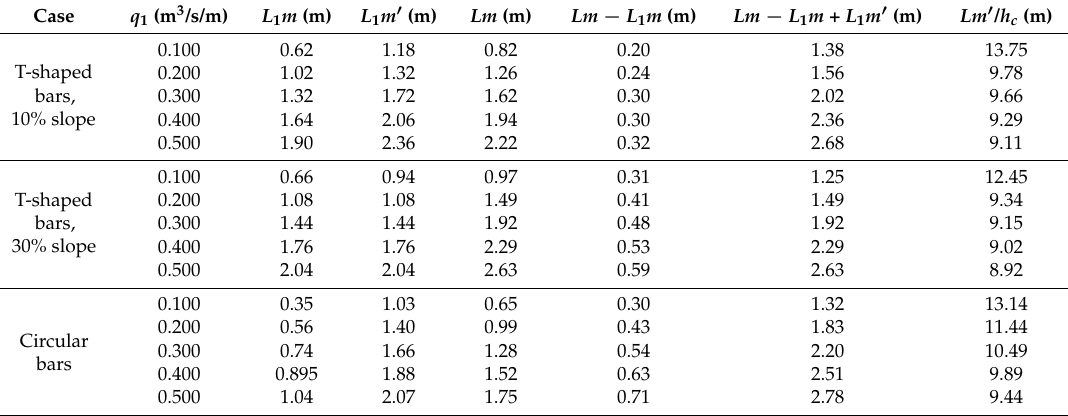
Table 6. Summary of lengths calculated to obtain the effective wetted rack length considering gravel-sized